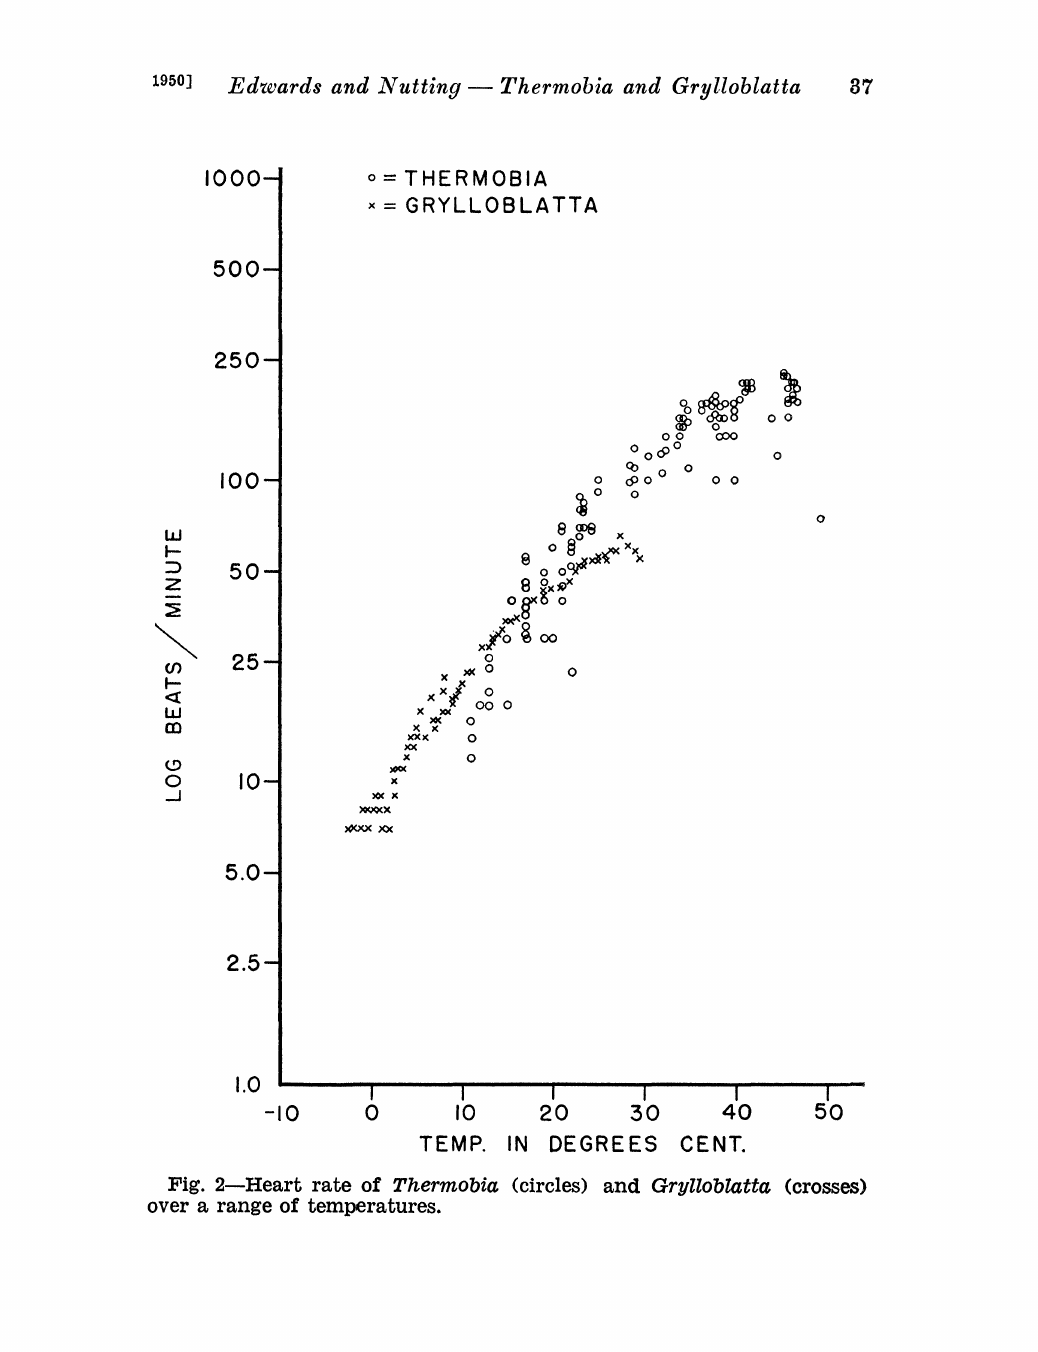
Fig. 2--Heart rate of Thermobia (circles) and Gryllobtatta (crosses) over a range of